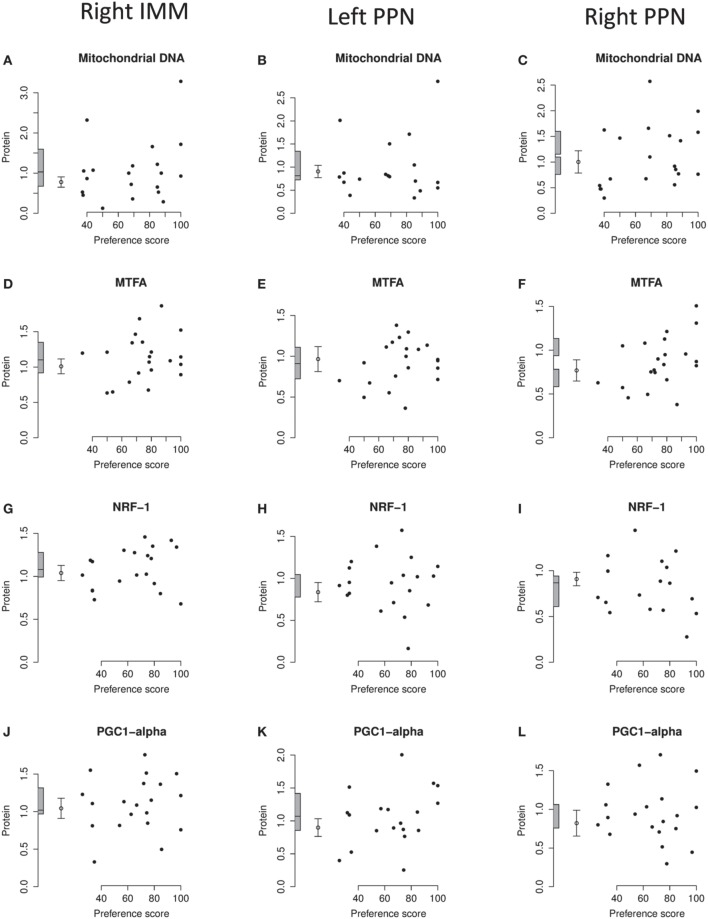
Right IMM and right and left PPN, standardized relative amounts of mitochondrial copy number and of MTFA, NRF-1, and PGC1-α plotted against preference score. (A–C), mitochondrial DNA; (D–F), MTFA; (G–I), NRF-1; (J–L) PGC1-α. Left-hand column right IMM, middle and right-hand columns left and right PPN, respectively. Conventions otherwise as for Figure 4.